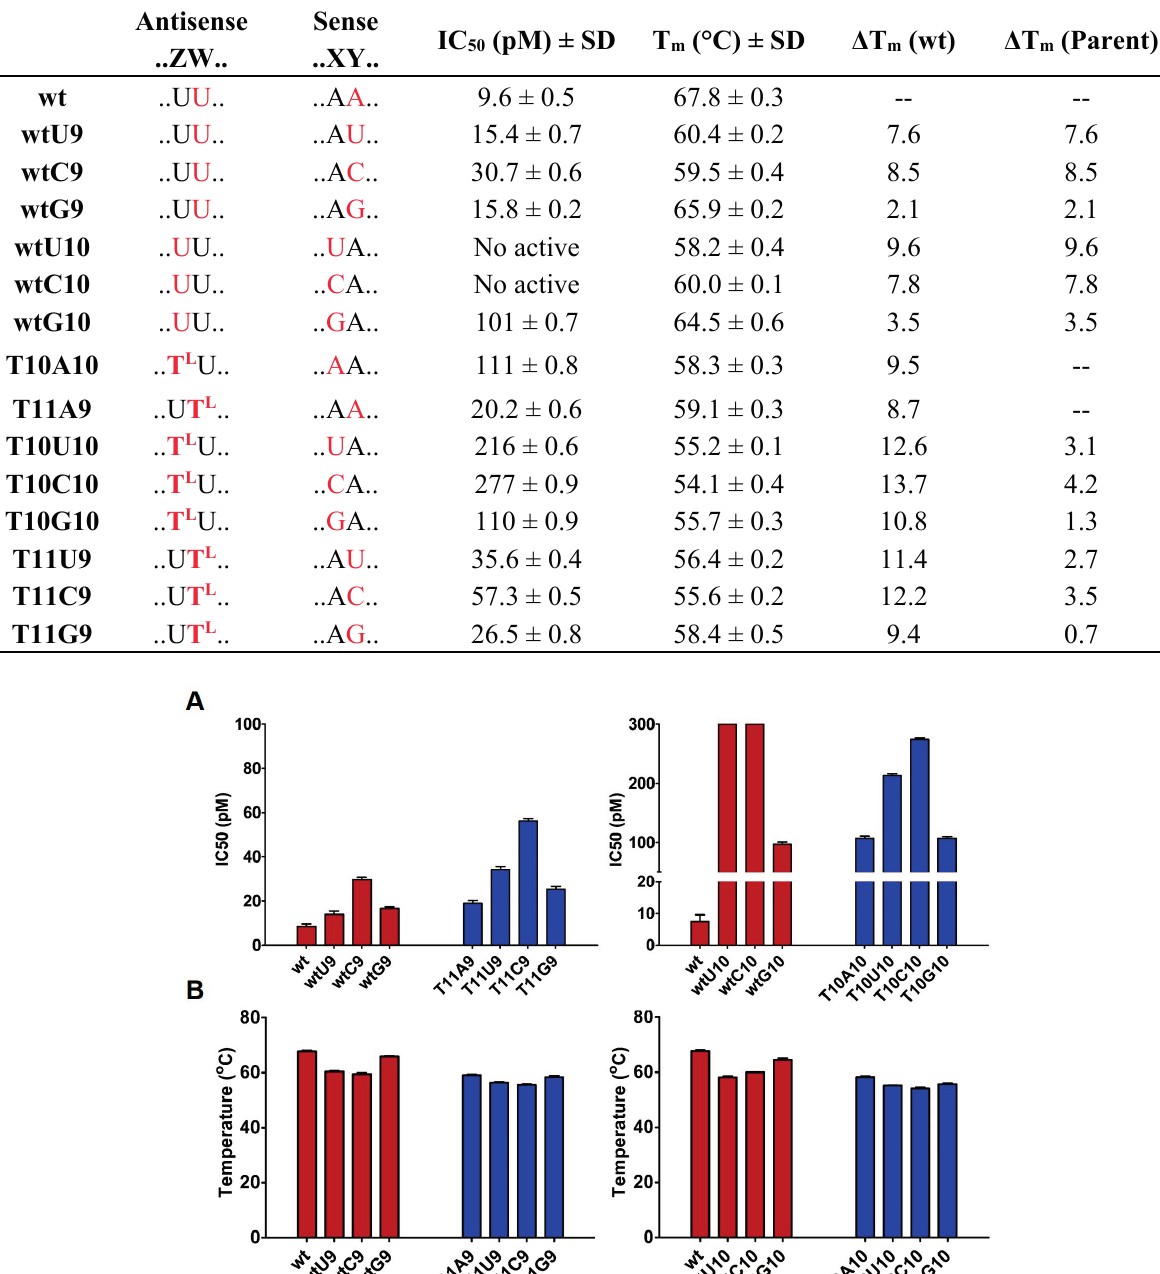
Figure 3. ( A ) IC 50 assessments of siRNA molecules. To achieve the IC 50 values, HeLa cells were co-transfected with psiCHECK2 ( AS ) reporter and decreasing amounts (1 nM, 0.3 nM, 60 pM, 16 pM, 8 pM and 2 pM) of siRNA molecules. Luminescence was evaluated 24 h after transfection. n = 3 ± SD; ( B ) Plot of siRNAs melting temperature used in luciferase study. n = 3 ±